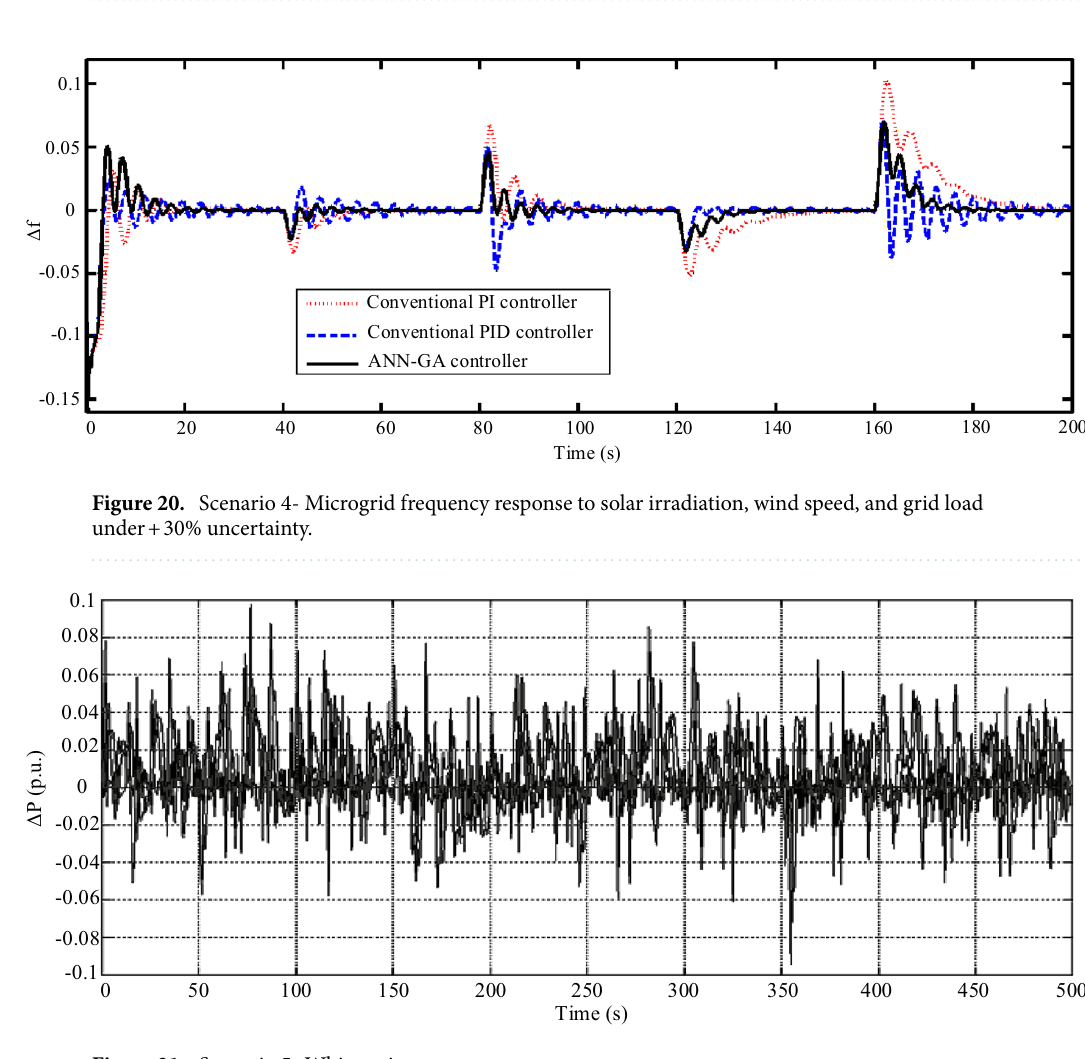
Figure 21. Scenario 5- White